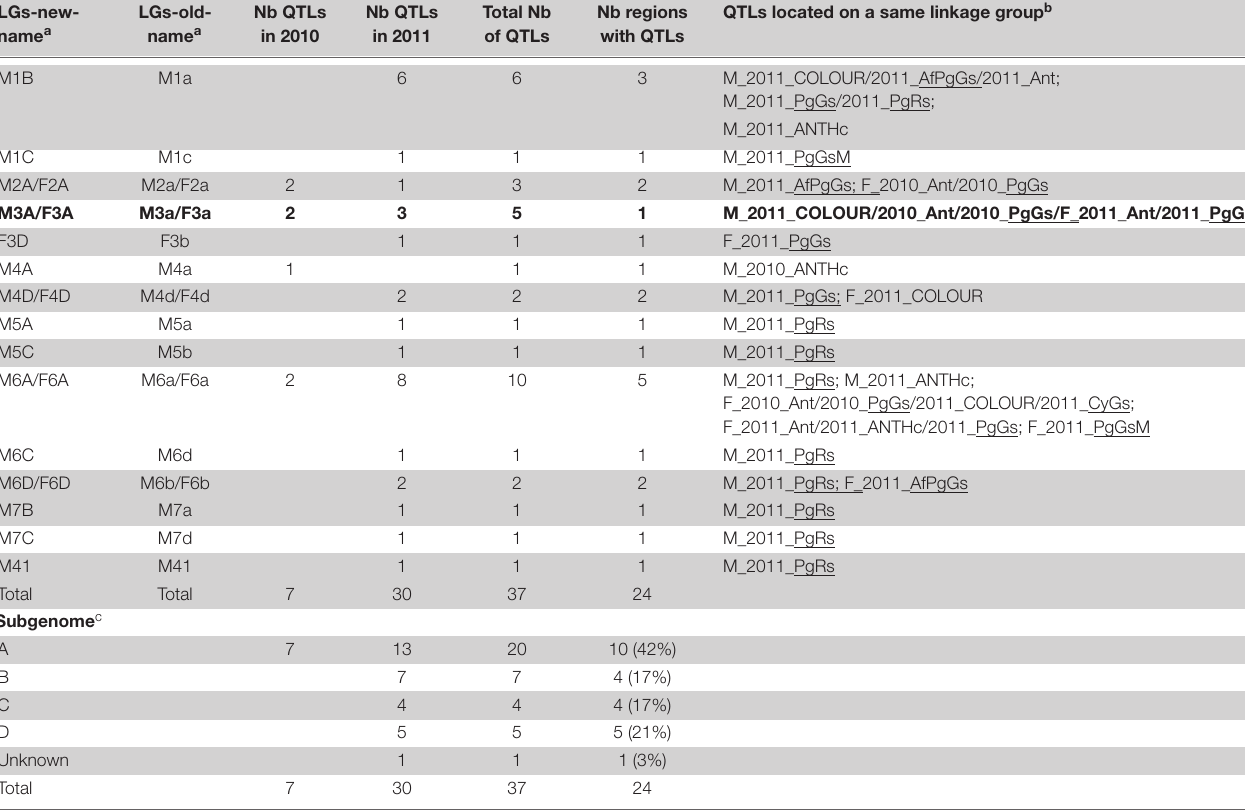
TABLE 1 | Distribution and number of significant quantitative trait loci (QTLs) detected for colour-related traits according to the male and female linkage groups (LGs), year and subgenomes. LGs-new- name